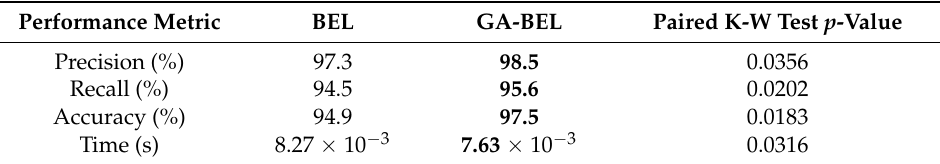
Table 2. Experimental results of BEL vs. GA-BEL on the Breast Cancer